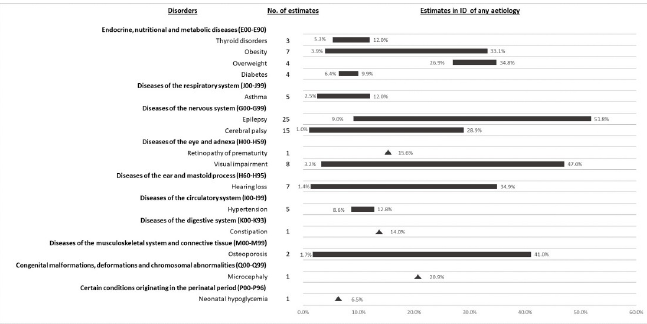
Fig 3. Prevalence range (%) of 15 most common physical health conditions in people with ID of any aetiology.